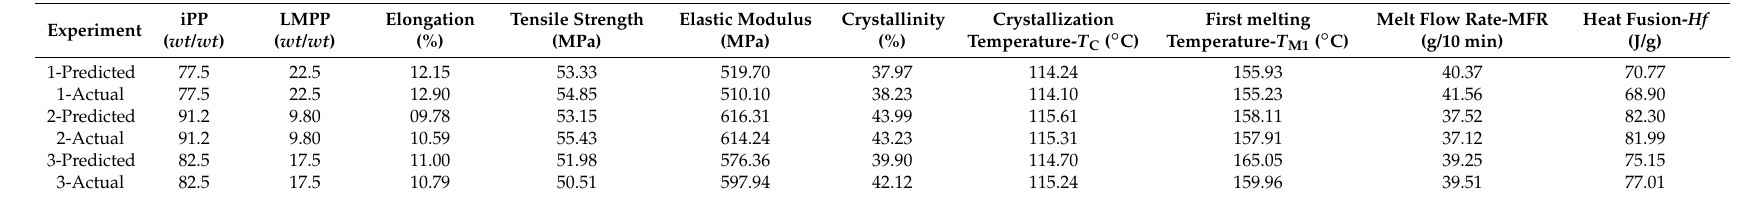
Table 3. Solutions for iPP/LMPP optimum conditions for blend fibres with desired